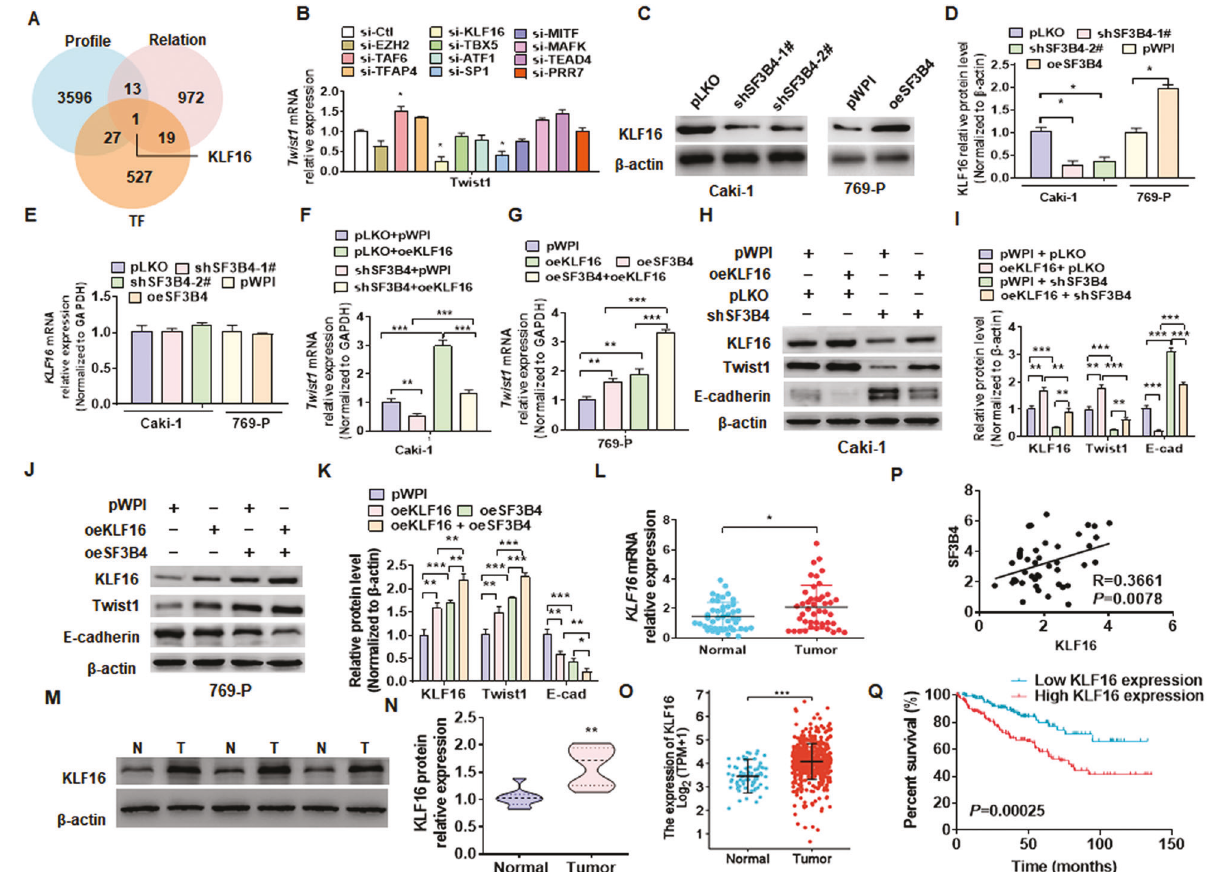
Fig. 5 KLF16 mediates SF3B4 upregulation of Twist1 expression. A Potential target genes of SF3B4 were analyzed from the data of gene transcriptome of SF3B4-depleted cells (Pro fi le), genes expressed in association with SF3B4 in ccRCC tissues in TCGA data (Relation) and transcription factor (TF), and are shown by a Venn diagram. B RT-qPCR detected the Twist1 mRNA expression in Caki-1 cells transfected with the indicated siRNAs for candidate transcription factors. C , D Western blot examined the KLF16 expression in Caki-1 and 769-P cells transfected with the indicated constructs. E Cells were transfected as in C and then RT-qPCR detected the KLF16 mRNA expression. F , G Caki-1, and 769-P cells were transfected as indicated, and then RT-qPCR detected the expression of Twist1 mRNA. H , I Caki-1 cells were transfected with pWPI-KLF16 (oeKLF16) and shSF3B4, alone or together, and then the protein levels of KLF16, Twist1, and E-cadherin were examined by western blot. J , K 769-P cells were transfected with oeKLF16 and oeSF3B4, alone or together, and then KLF16, Twist1, and E-cadherin were examined by western blot. L KLF16 mRNA expression was detected by RT-qPCR in normal (N, n = 53) or ccRCC (T, n = 53) tissues. M KLF16 protein level was examined by western blot from three pair of randomly selected clinical ccRCC samples. N Quantitative analysis of M . O The expression level of KLF16 was downloaded and then analyzed from data of the TCGA database in normal ( n = 72) and ccRCC ( n = 533) tissues. P The correlation between SF3B4 and KLF16 mRNA level in ccRCC tissues was analyzed by Pearson correlation analysis of our clinical data ( R = 0.3661, P = 0.0078). Q According to the TCGA database, the overall survival for ccRCC patients with low and high Twist1 levels were analyzed by using the Kaplan – Meier method. All data are expressed as the mean ± SEM of three independent experiments. * P < 0.05, ** P < 0.01, *** P < 0.001 vs. their corresponding